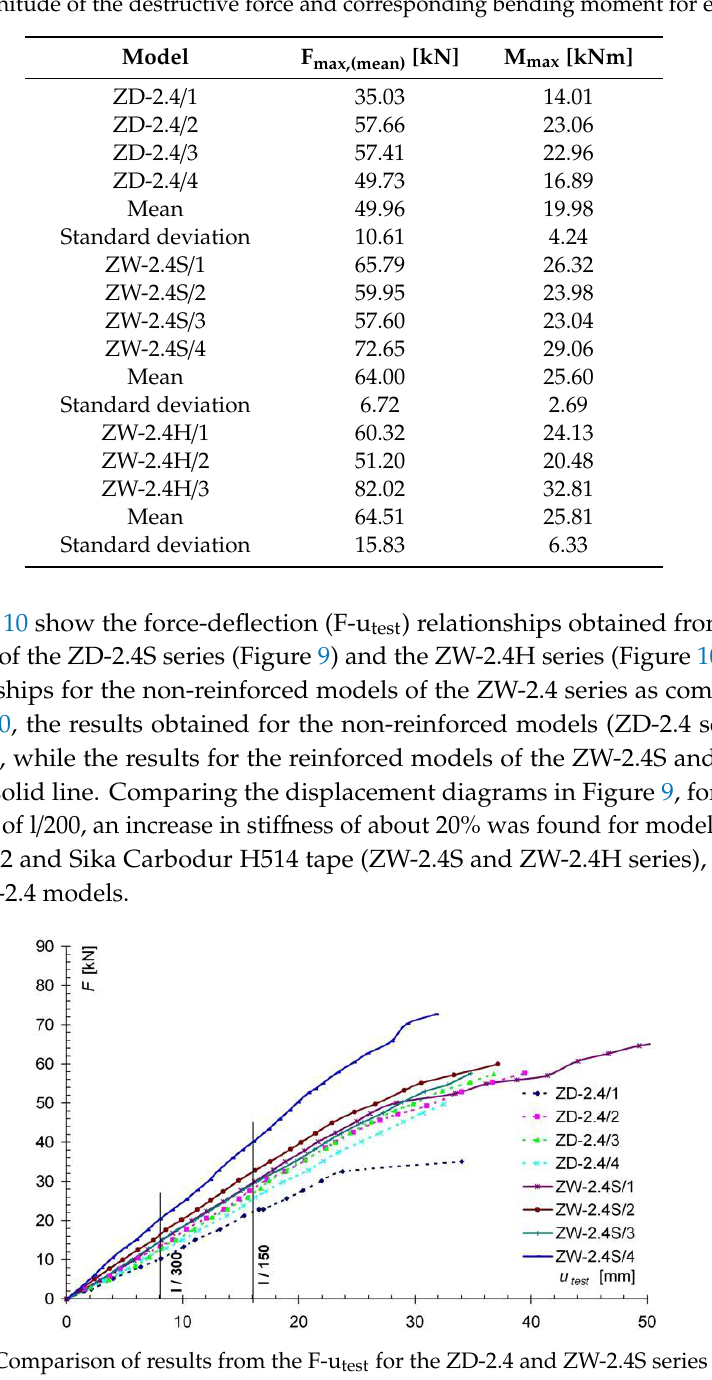
Figure 10. Comparison of results from the F-u test for the ZD-2.4 and ZW-2.4H series models.